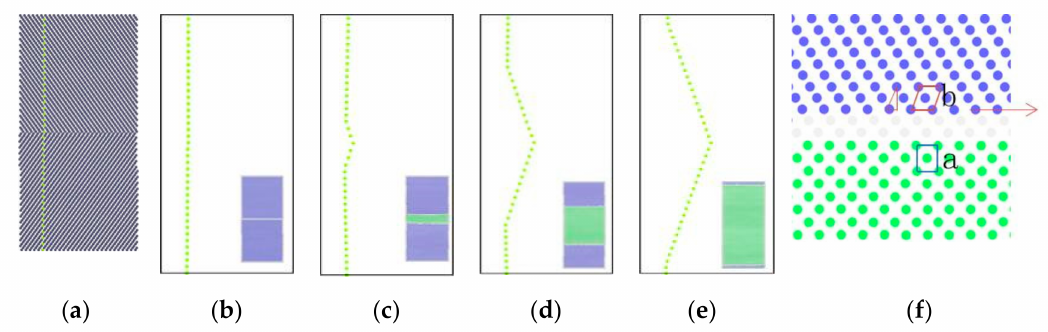
Figure 7. Atomic trajectories in the tensile process without Cu clusters ( a ) the selection model to observe atoms ( b ) strain 0–8.5% when selected atomic position ( c – e ) strain were 9%, 16% and 22.5%, respectively, when the structural phase transformation in the atomic positions ( f ) and not structural phase transition area enlarge figure thumbnail in the green part of the blue part for the FCC structure to BCC